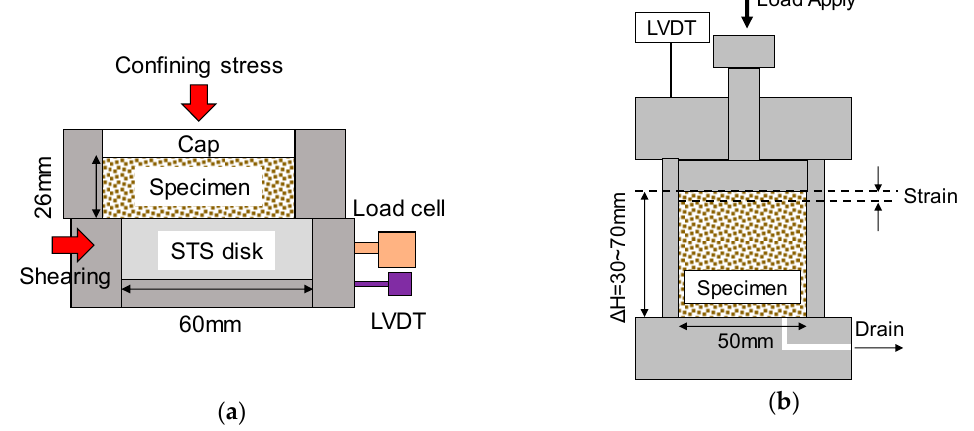
Figure 2. Schematic diagram of lab-scale tests: ( a ) direct shear test; ( b ) consolidation test.